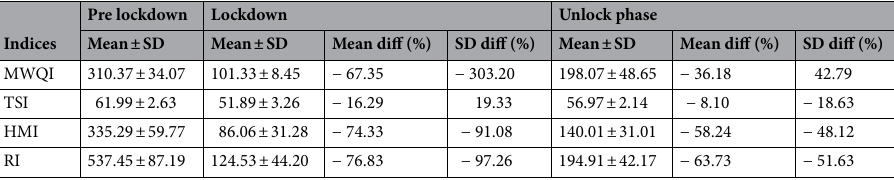
Table 3. Values of MWQI, TSI, HMI and RI in three sessions.